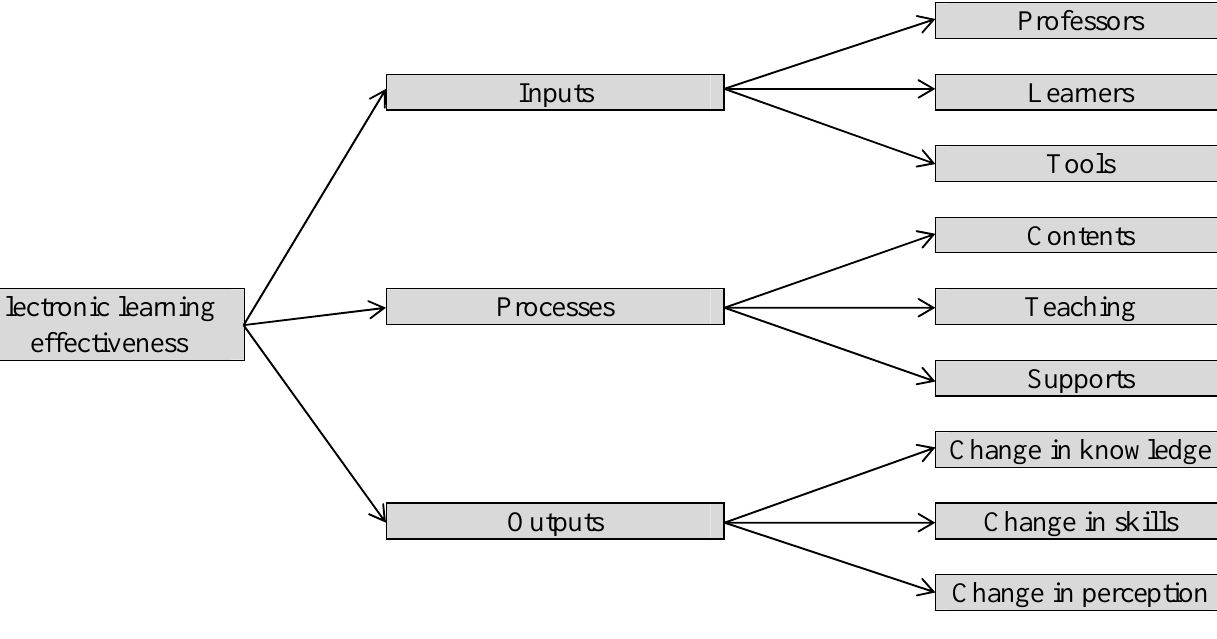
Fig. 1. The framework of the proposed